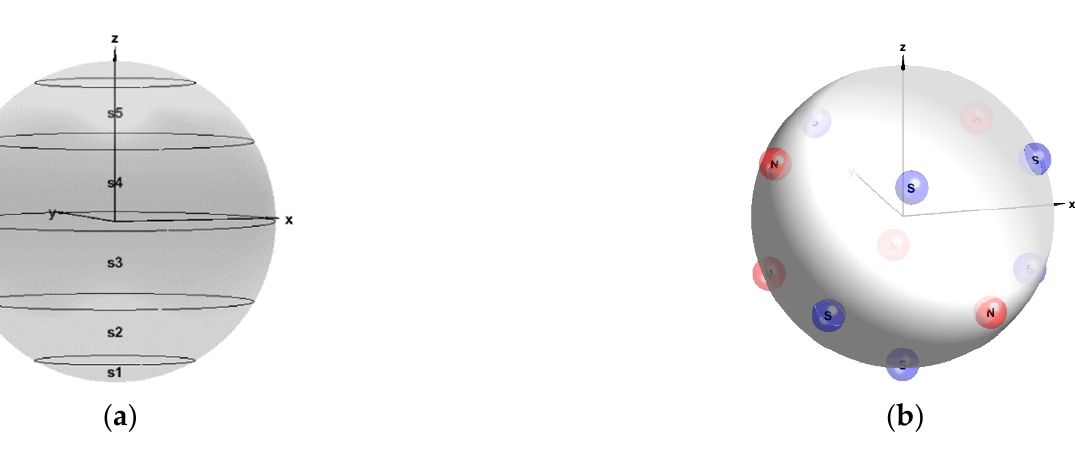
Table 2. Normalized x , y , z coordinates and polarity of rotor PMs.